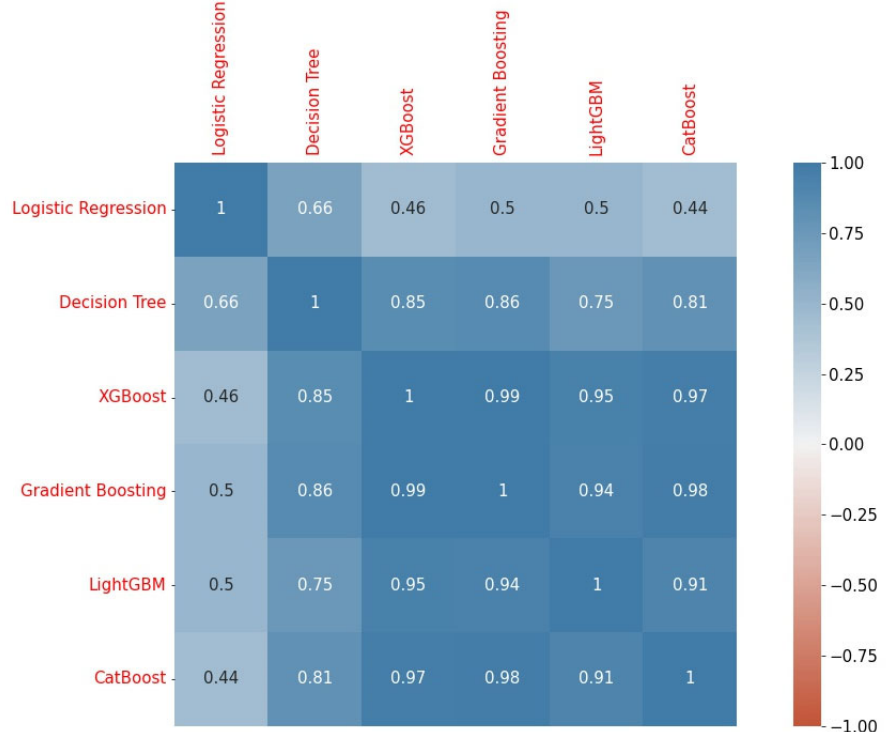
Figure 7. The values of the Spearman rank coefficient of correlation between the positions of the independent variables in the feature importance rankings based on SHAP values for different machine learning methods.